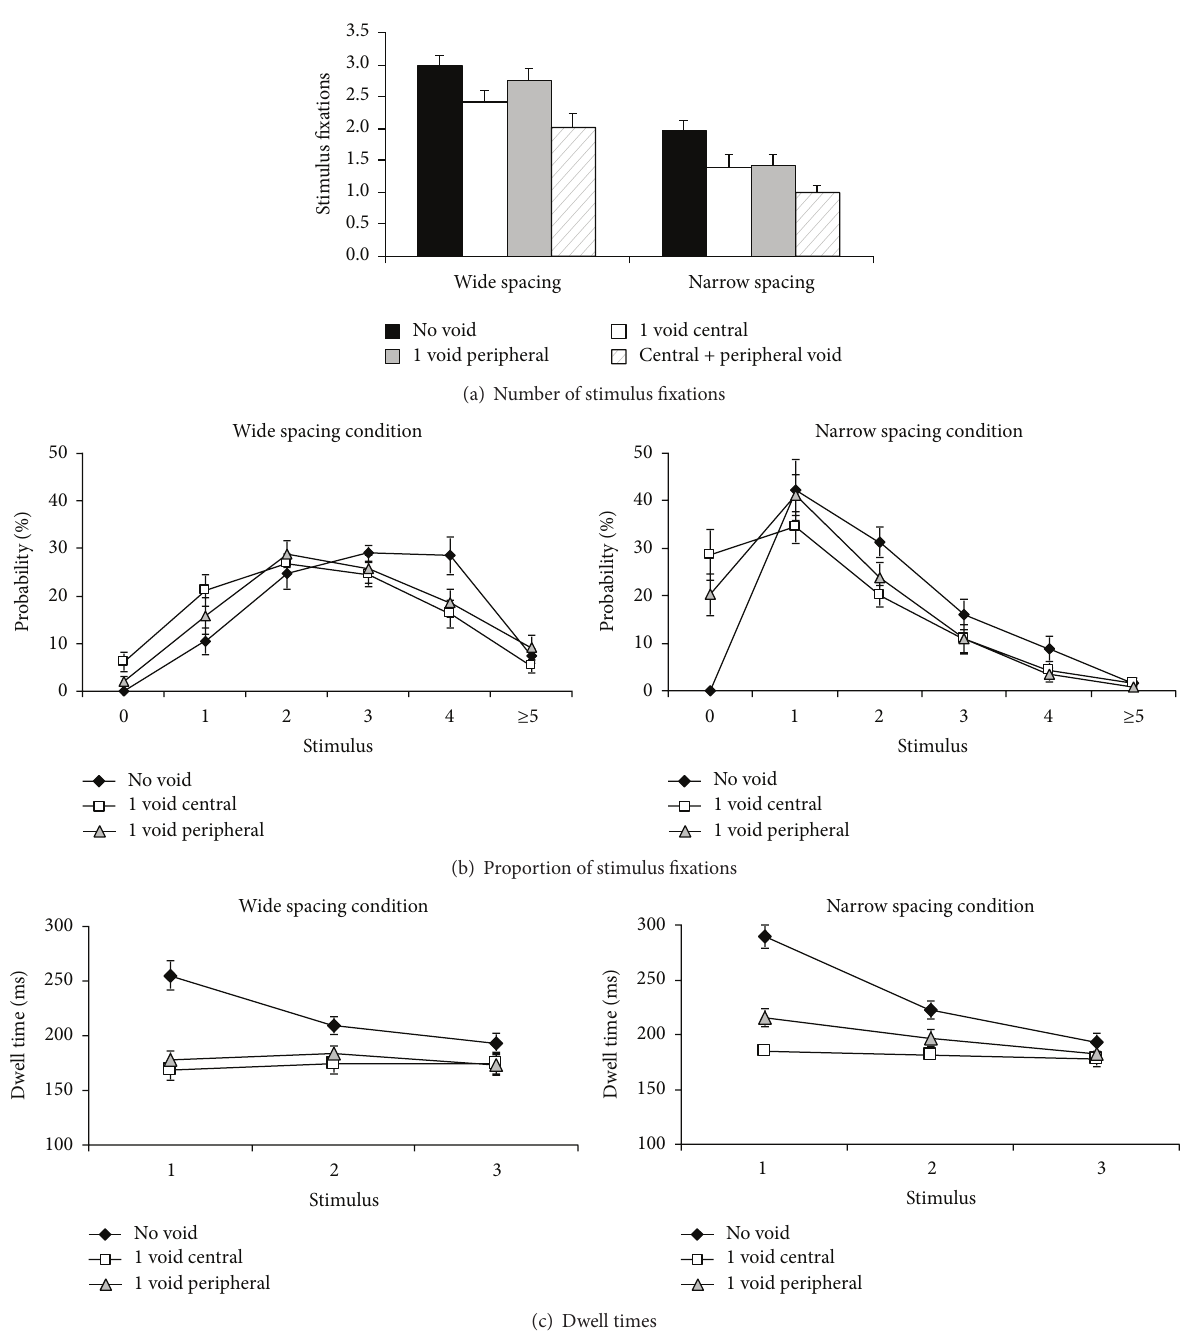
Figure 3: Effects of void fixations on stimulus fixations within a cluster. (a) The mean number of stimulus fixations within a cluster, depicted separately for instances in which there were no void fixations, one central or peripheral void fixation, and both central and peripheral void fixations into the cluster. Error bars depict ± 1 SEM and may be smaller than the plotting symbol. (b) The mean proportion of stimulus fixations within a cluster, depicted separately for instances in which 0, 1, 2, 3, 4, 5, or more stimulus fixations were made into a cluster. Results are depicted separately for the wide and narrow spacing conditions. (c) The mean dwell times of stimulus fixations within a given cluster, when observers had made 1, 2, or 3 stimulus fixations into a cluster, depicted separately for instances in which no void fixations, a central void fixation, or peripheral void fixations have been made into the